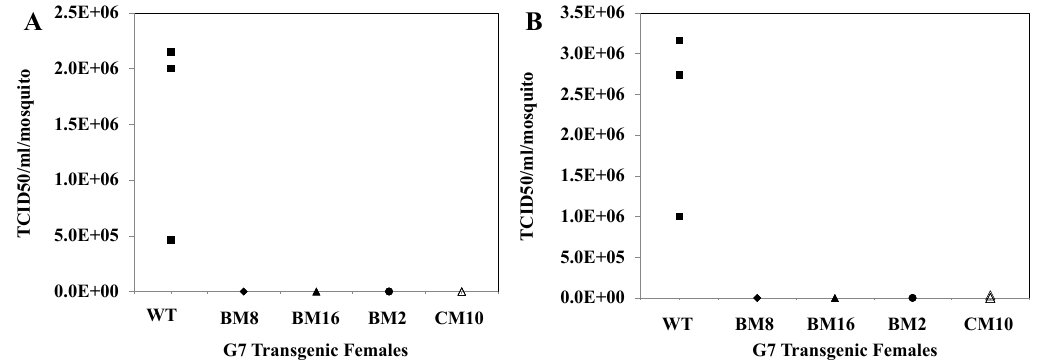
Figure 9. Saliva titers performed on G 7 transgenic mosquitoes challenged with CHIKV. Three pools of 15 female mosquitoes were collected at seven days post blood feeding for each transgenic line and were allowed to probe a feeding solution for 2 h. TCID 50 -IFA was performed on both the feeding solution ( A ) and whole body homogenates ( B ) of the mosquito pools. None of the transgenic lines tested exhibited significant viral titers compared with the control (WT).